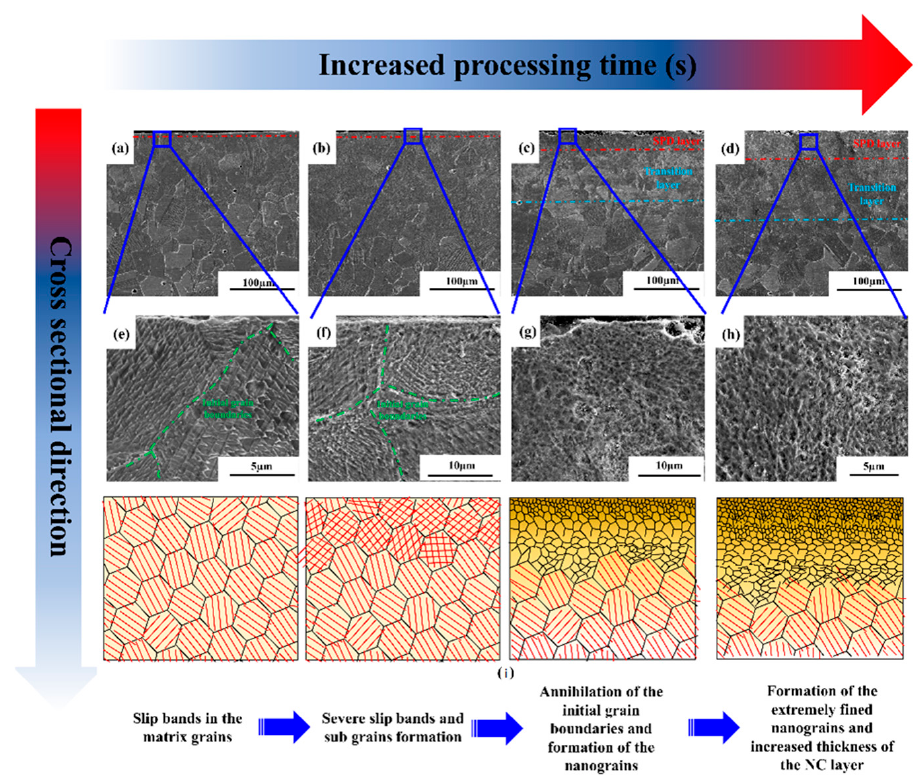
Figure 5. SEM characterizations of ultrasonic shot peened 316L stainless steel with peening periods of ( a ) 60 s, ( b ) 120 s, ( c ) 240 s, and ( d ) 600 s; magnified characterizations of the as-fabricated 316L stainless steel indicated by the blue rectangle with peening duration of ( e ) 60 s, ( f ) 120, ( g ) 240 s and ( h ) 600 s; ( i ) scheme of the microstructure evaluation of 316L stainless steel subjected to USP with different peening